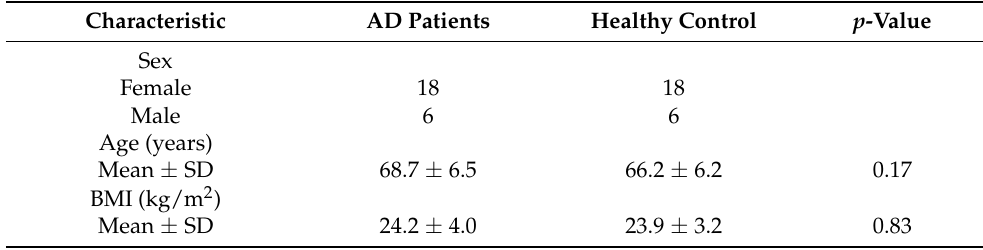
Table 1. Demographics of Alzheimer’s disease (AD) patients and control subjects.